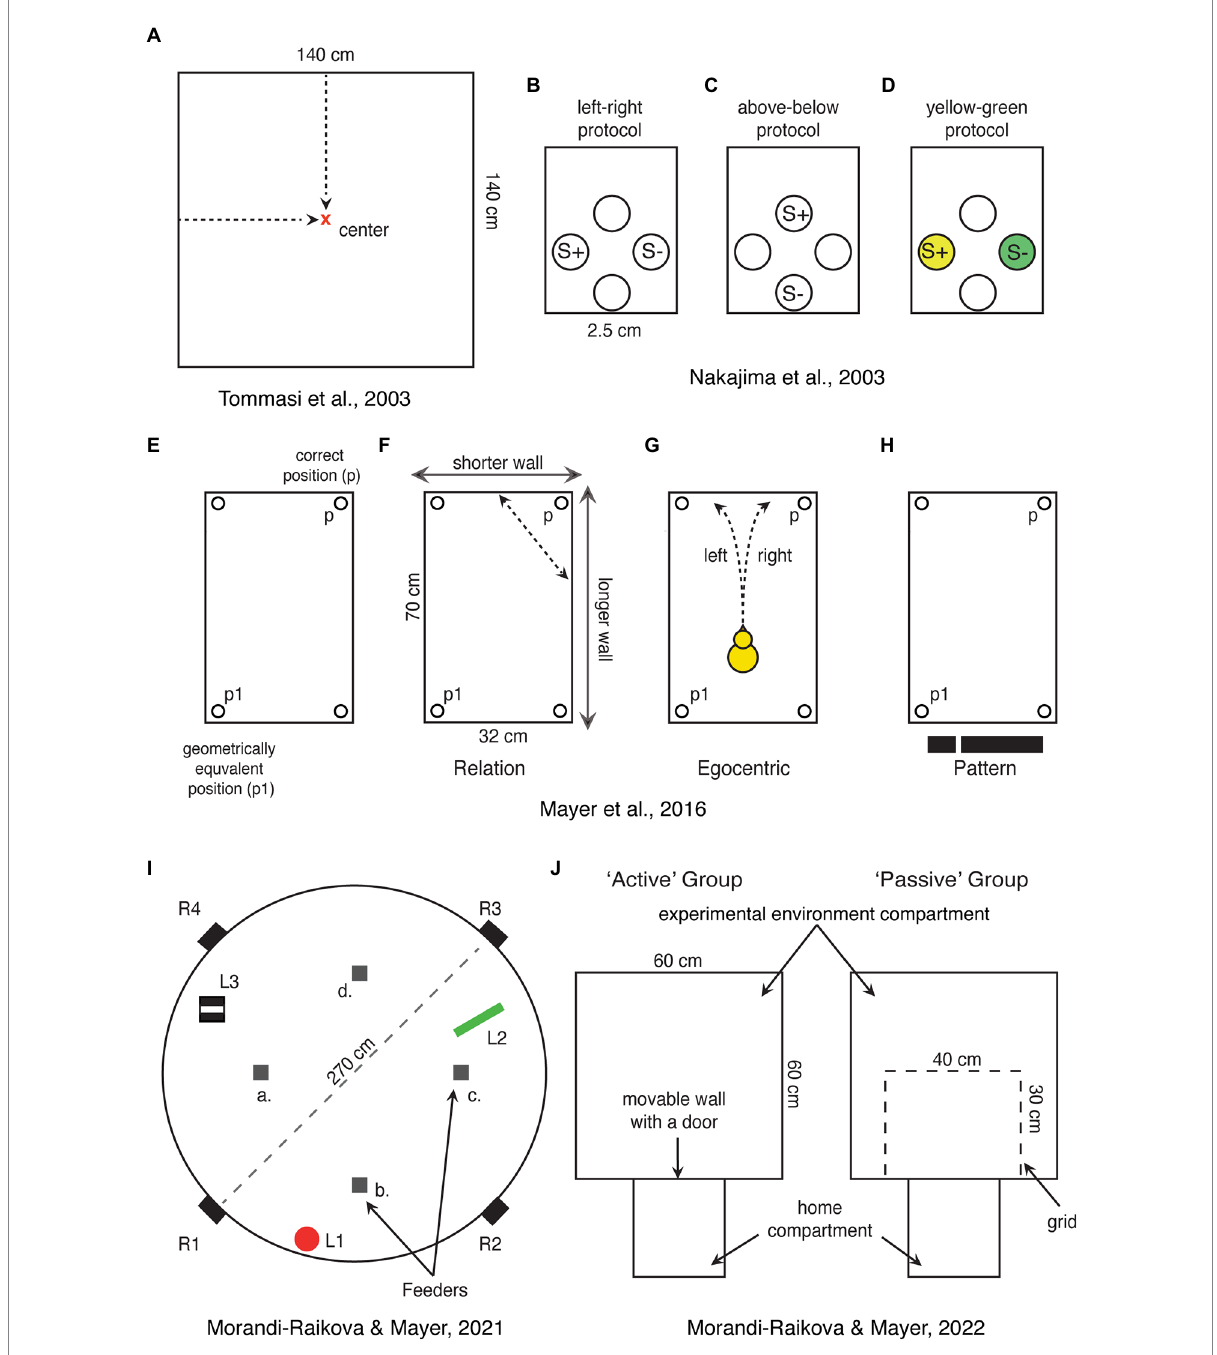
FIGURE 2 Schematic representations of spatial tasks that have been used for direct investigation of hippocampal involvement in domestic chicks. (A) Chicks are trained to find the center of a square-shaped arena, which can be encoded in relation to the walls or based on distance information. (B–D) View point dependent egocentric task, where chicks are trained to discriminate rewarded holes in one of the walls of the apparatus based on left–right or up–down positions or associated colors. S+ and S-represent rewarded and not rewarded positions, respectively. (E) Rectangular shaped arena used in the “Cheng” task, showing the correct position (p) and its geometrical equivalent (p1). (F–H) Alternative strategies that can be used to solve the “Cheng” task. In (H) , the black stripe represents the visual pattern provided by the short wall on the left and long wall on the right. (I) A large circular arena with free standing objects (L1—a red cylinder, L2—a green triangle, and L3—a striped box.), which can be used as a reference for finding the position of one rewarded feeder among four identical ones ( a–d ) . In the alternative version of the task, the rewarded feeder can be marked by a distinct local cue. Chicks were released from four entrances (R1–R4) to disrupt egocentric orientation. (J) Experimental setup used to test the role of active exploration of a novel environment. Chicks were trained to enter the “experimental environment” through an open door. The active exploration group chicks could enter the “experimental environment” and actively explored it. Chicks of the “passive exploration” group could see the “experimental environment” through a grid, but not explore it